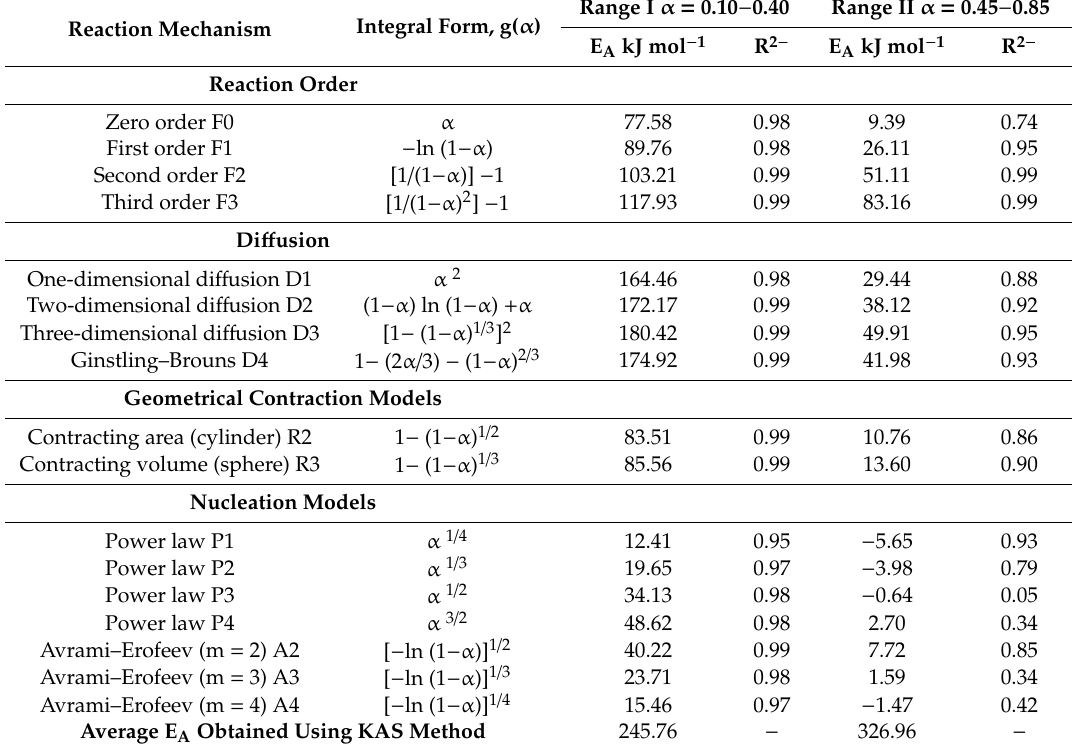
Table A3. The activation energy for BSG calculated using Coats–Redfern method and several di ff erent reaction mechanisms, The reaction mechanisms and their equations are adapted from